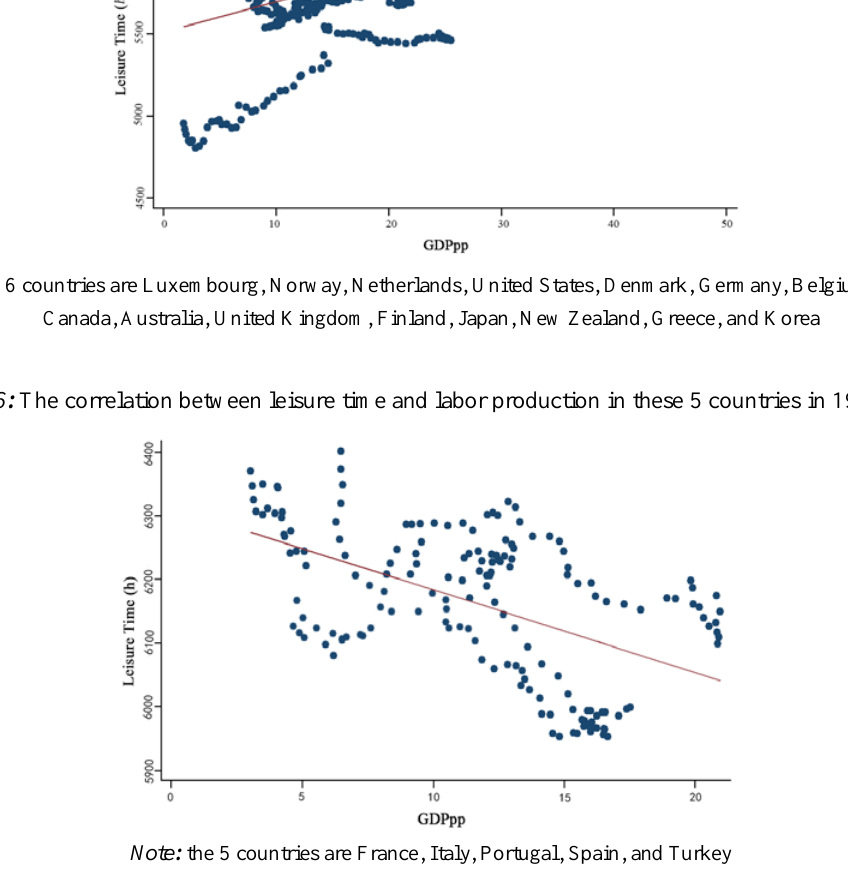
Note: the 5 countries are France, Italy, Portugal, Spain, and